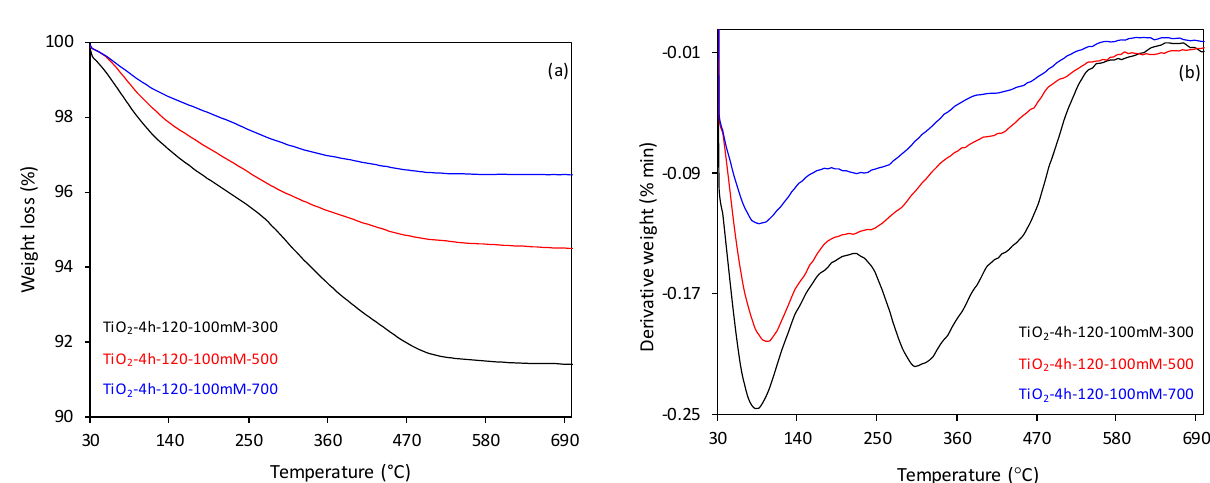
Figure 3. ( a ) TG and ( b ) DTG curves of the unmodified samples calcined at various temperatures.